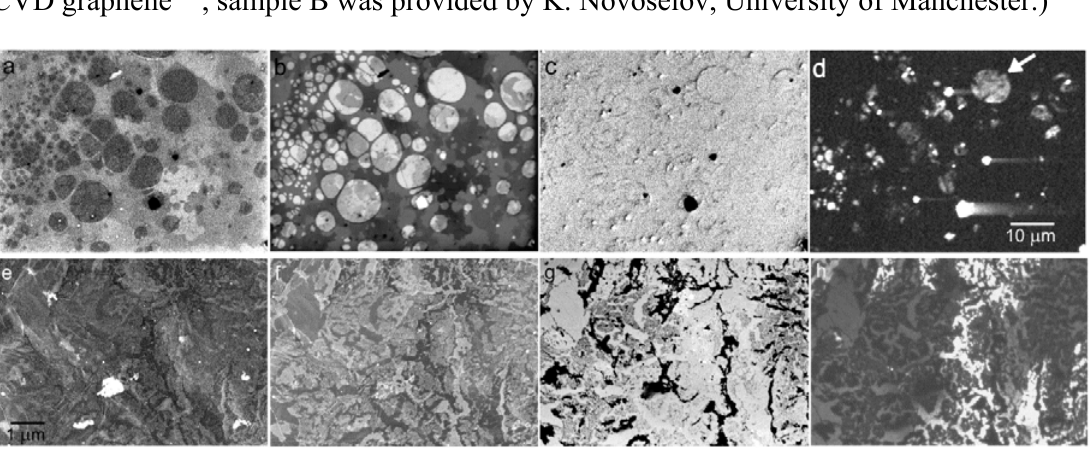
Figure 23. Micrographs of two graphene samples in combined reflection and transmission modes. ( a ) sample A, BSE at 3 keV; ( b ) sample A, TE at 3 keV; ( c ) sample A, BSE at 4 eV; ( d ) sample A, TE at 4 eV; ( e ) sample B, BSE at 5 keV; ( f ) sample B, BSE at 1 keV; ( g ) sample B, TE at 500 eV; ( h ) sample B, TE at 20 eV. (Sample A was purchased as